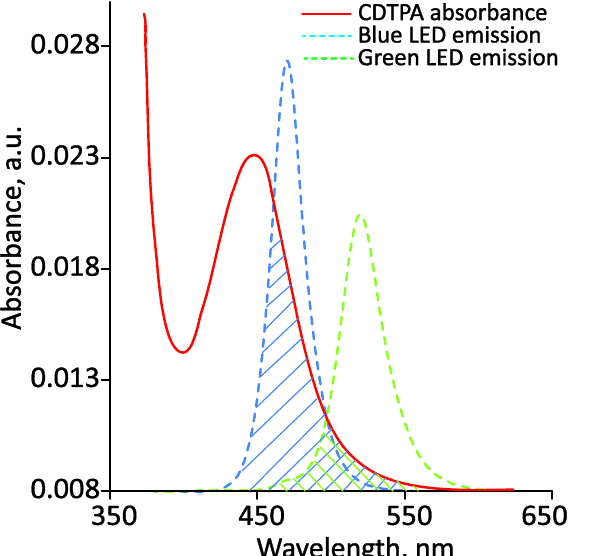
Figure 4. Absorption spectrum of photoiniferter (CDTPA) measured using UV–Vis spectroscopy, and emission spectra of green and blue LEDs. The peaks of the emission spectra were at 470 and 520 nm for blue and green LEDs, respectively.